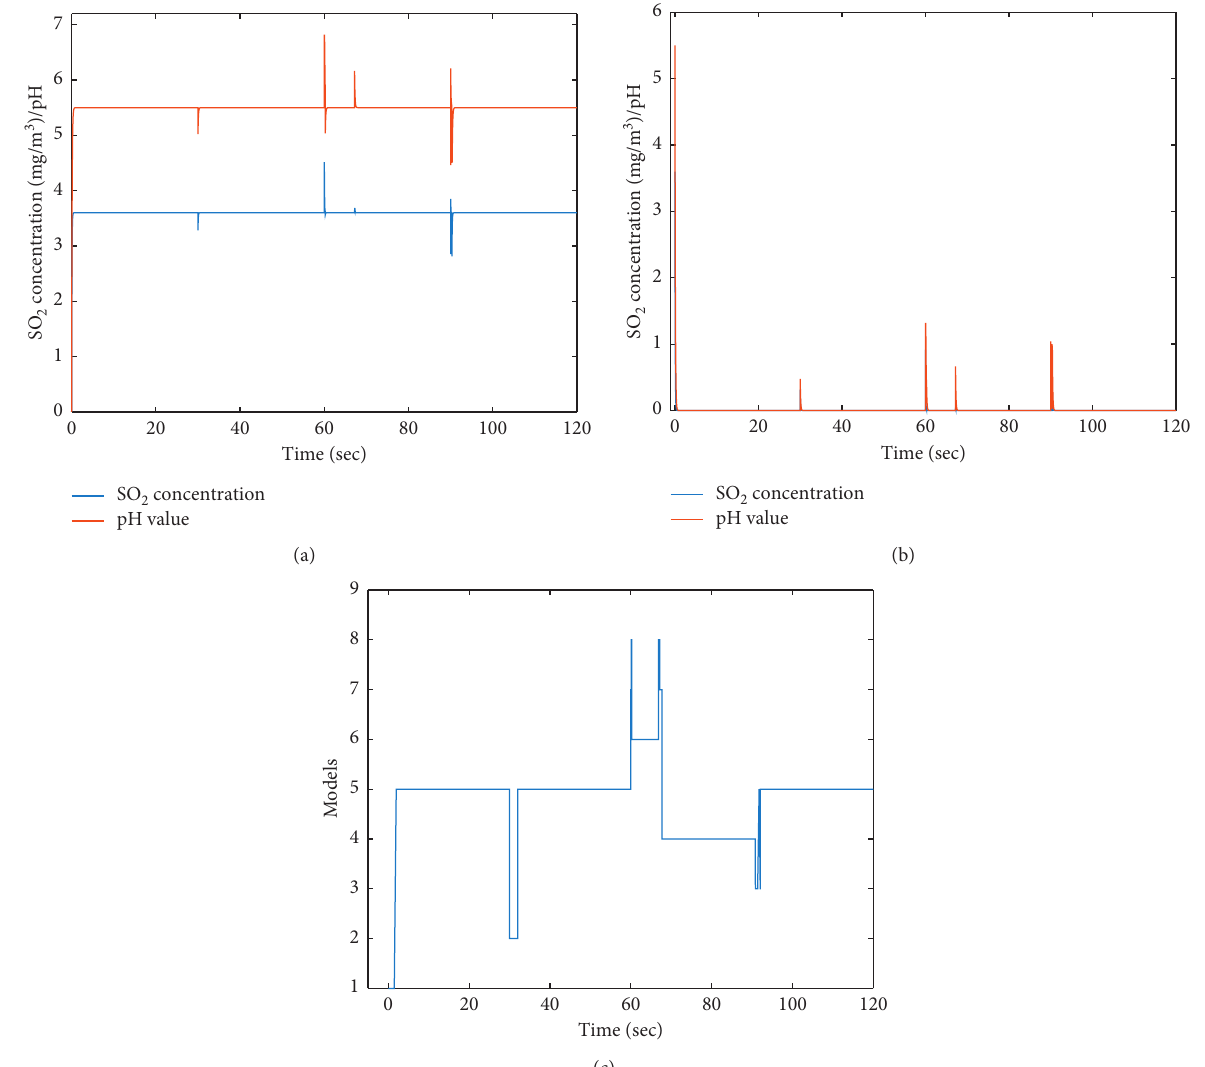
Figure 14: Control response of Case 4: (a) system outputs; (b) absolute value of the control error; (c) switching